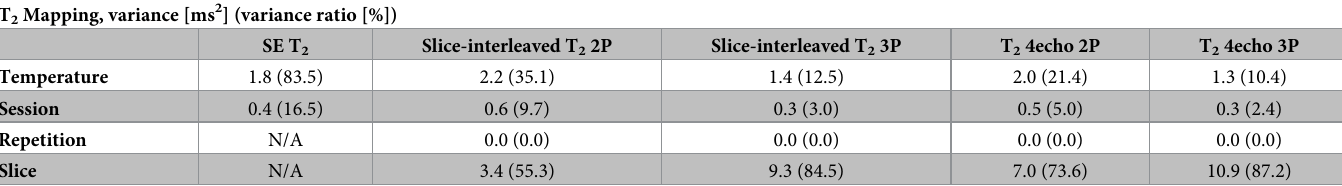
Table 4. Sources of variability in T 2 mapping defined by the variance decomposition analysis.